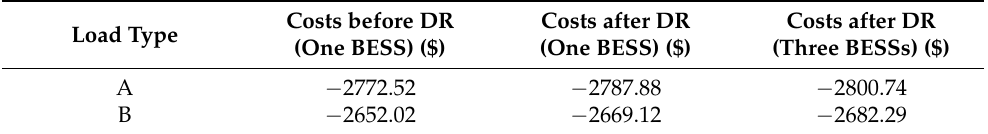
Table 5. Comparison of the total operation costs in terms of DR implementation and different quantities of BESSs (the distribution operator is able to sell electricity to the utility grid). Costs before DR Costs after DR Costs after Load Type (One BESS) ($) (One BESS) ($)